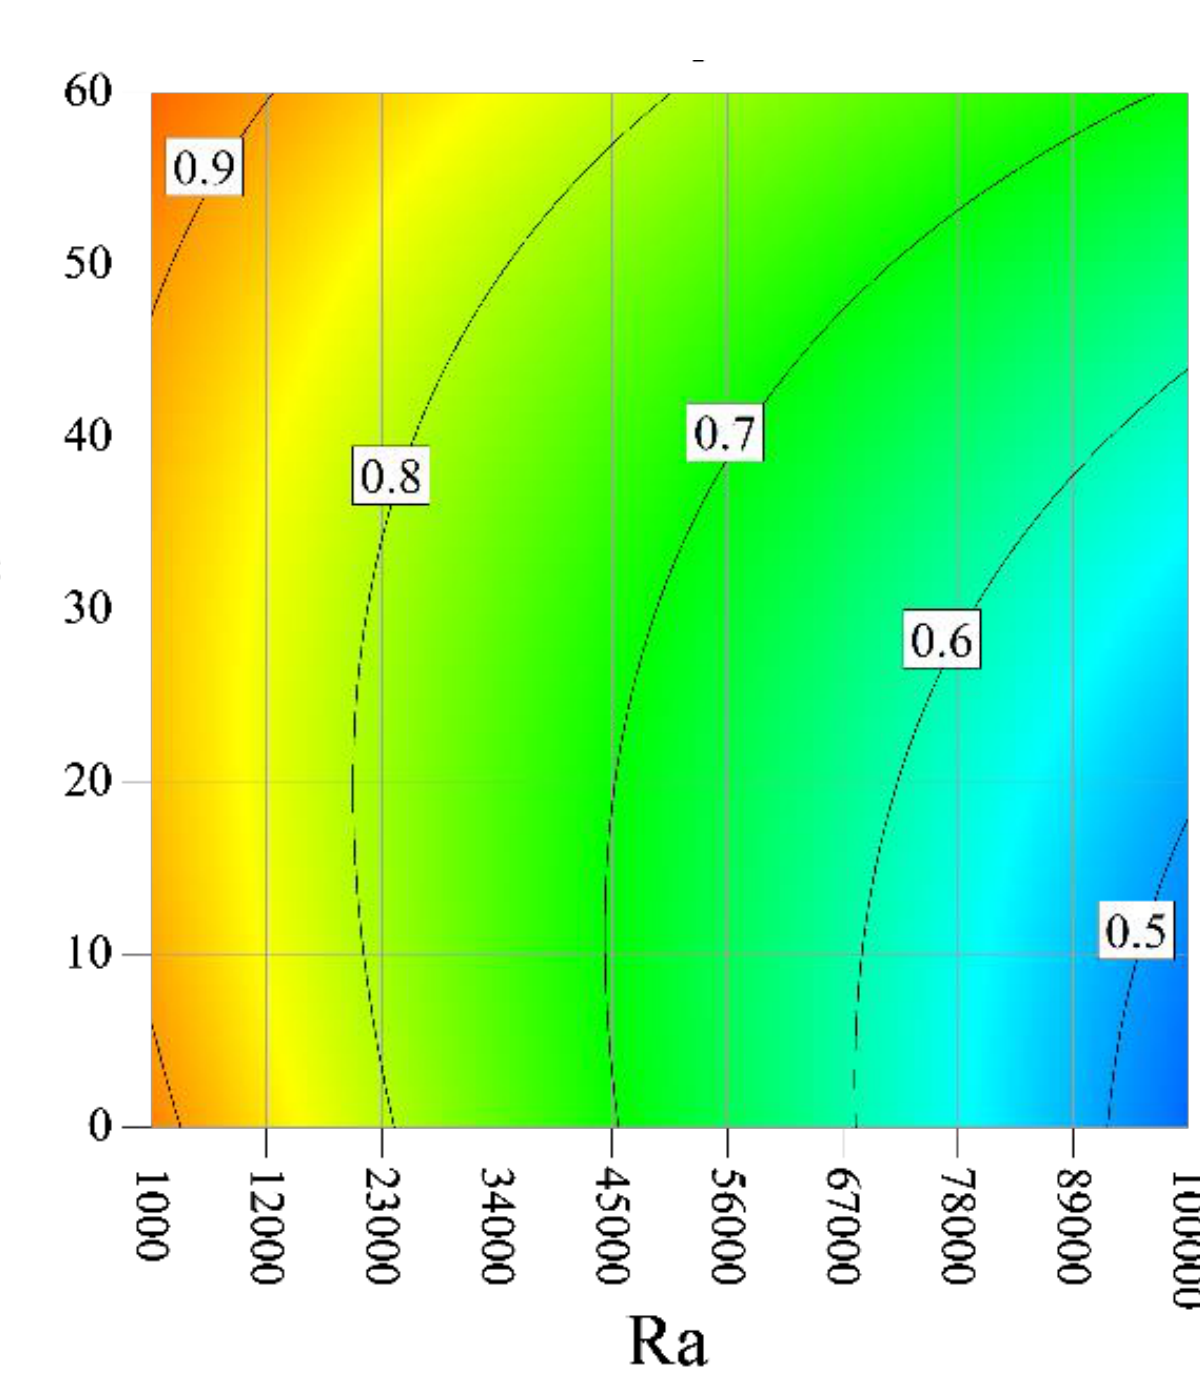
Figure 12. Be for different Ra and Ha when W = 0.5 and H = 0.7, and volume fraction is 0.3%. Figure A12. Be for different Ra and Ha when W = 0.5 and H = 0.7, and volume fraction is